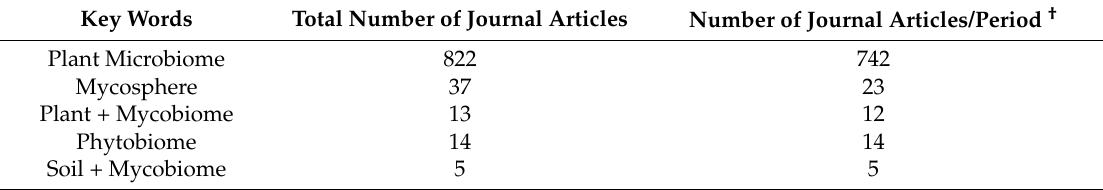
Table 1. Journal articles dealing with symbiotic plant and soil